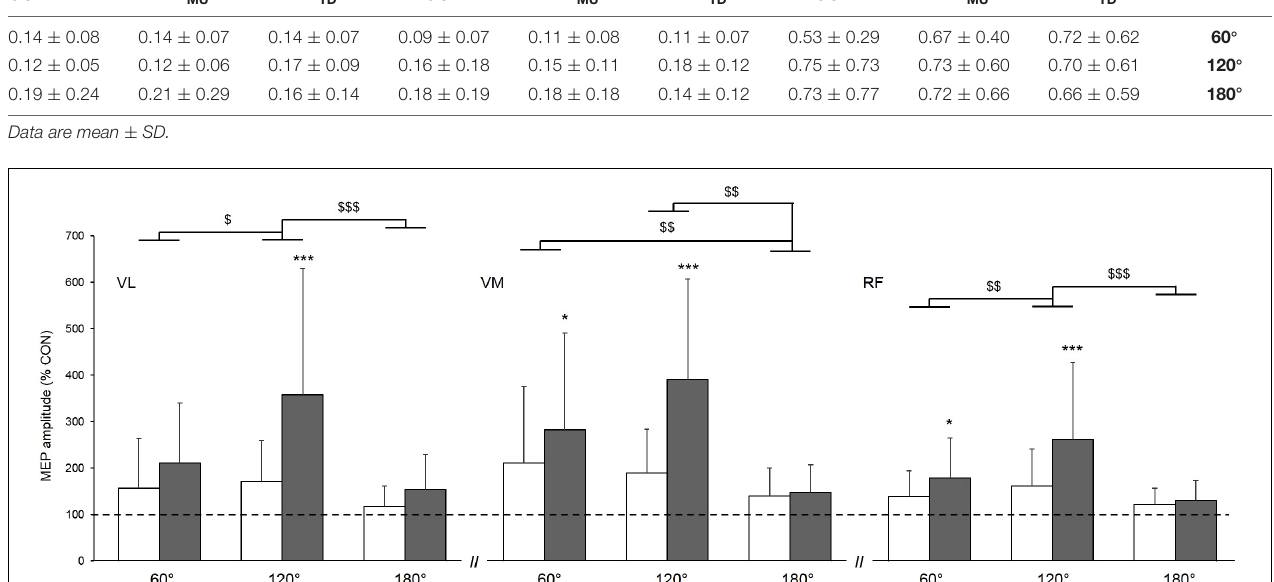
FIGURE 3 | Effect of muscle (white column) and tendon (gray column) vibration on MEP amplitudes of vastus lateralis (VL), vastus medialis (VM), and rectus femoris (RF) muscles at muscle lengths corresponding to knee angles of 60, 120, and 180 ◦ . MEP amplitudes are expressed as a percentage of the mean control MEP (CON) elicited at rest without vibration. Mean control MEP (i.e., 100% on the figure) is represented by the dahsed line. Condition × angle interaction effect: ∗ p < 0.05; ∗∗∗ p < 0.001. Main angle effect: $ p < 0.05; $$ p < 0.01; $$$ p < 0.001.